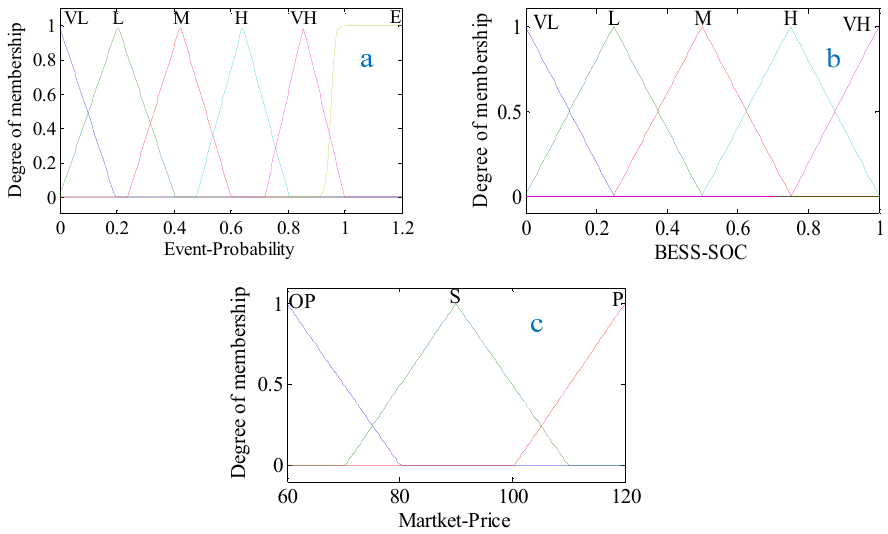
Figure 6. Membership functions: ( a ) event probability; ( b ) BESS SOC; ( c ) market price signals.